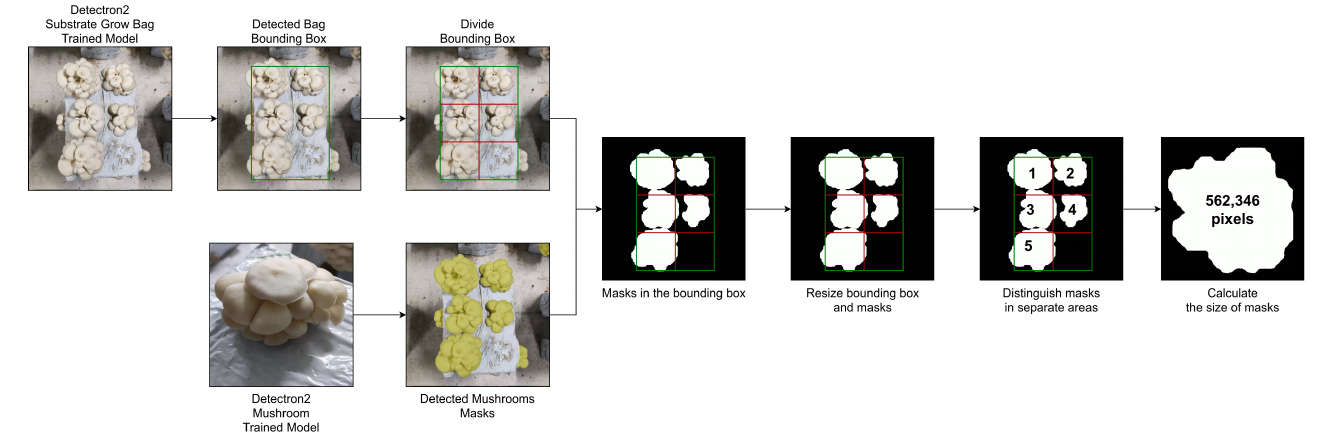
Figure 5. Main components of the architecture for mushroom growth